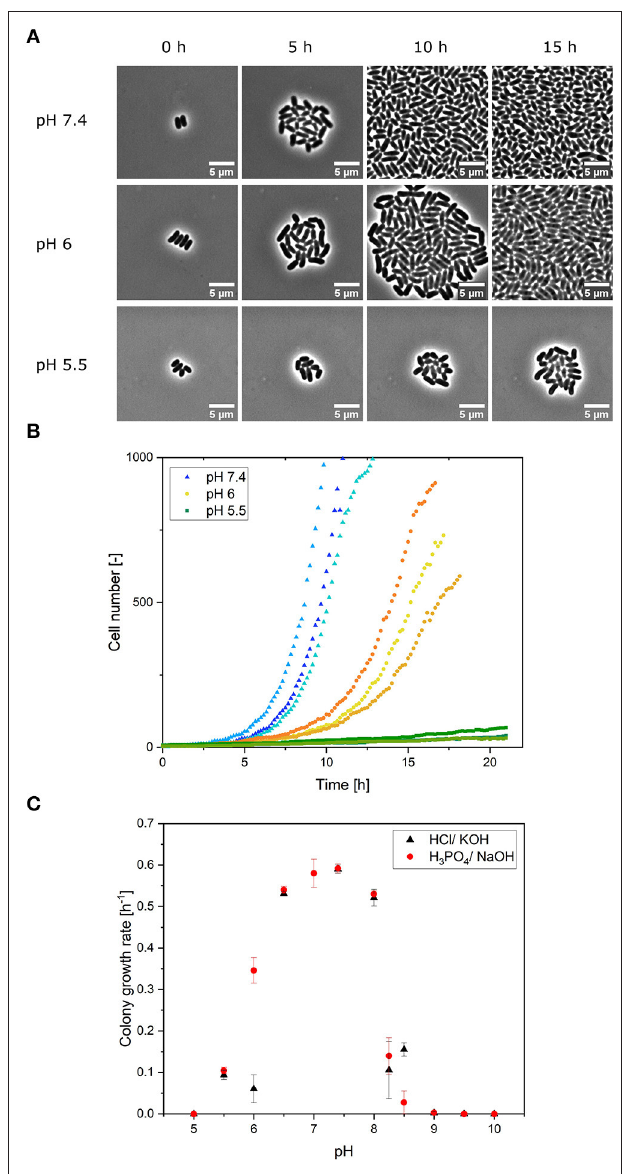
FIGURE 2 | (A) Microscope images of growing colonies in constant pH conditions of pH 7.4, 6 and 5.5 at different points in the cultivation time. Scale was set to 5 µ m. (B) Colony growth of C. glutamicum at different, constant pH values (5.5, 6, 7.4) using NaOH and H 3 PO 4 for pH adjustment. Three colonies (biological replicates) are shown for each pH value in different shades of the same color. (C) Optimal pH curve for the colony growth of C. glutamicum on a microfluidic chip in CGXII medium. The error bars represent the standard deviation for each pH value. For each pH value experiment, n = 3 cultivation chambers were analyzed. Each calculated colony growth rate represents an average of ∼ 512 division